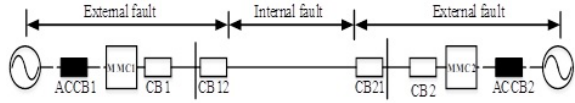
Fig. 4. Diagram of fault interval division. fault and its removal is controlled within 5